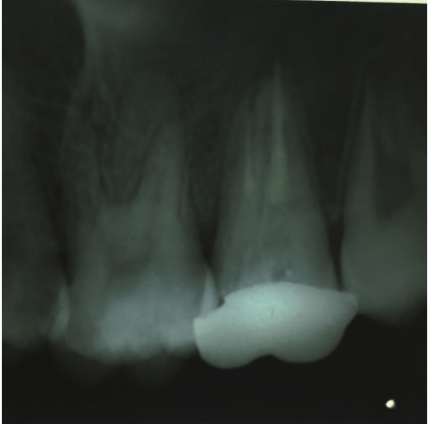
Figure 16: Radiograph showing external reinforcement with metal crown in tooth